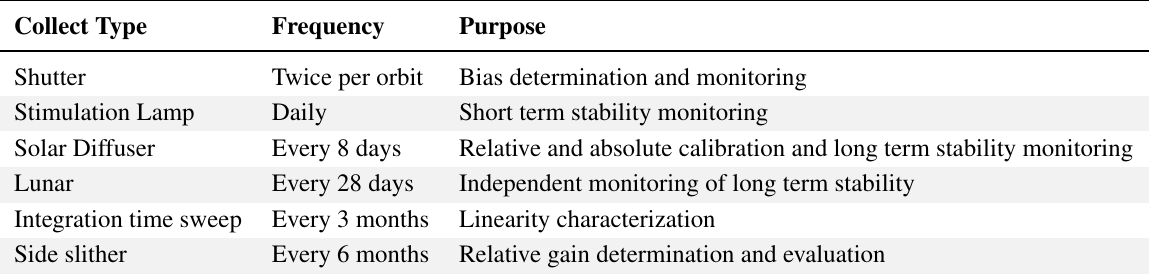
Table 2. Operational Land Imager Data